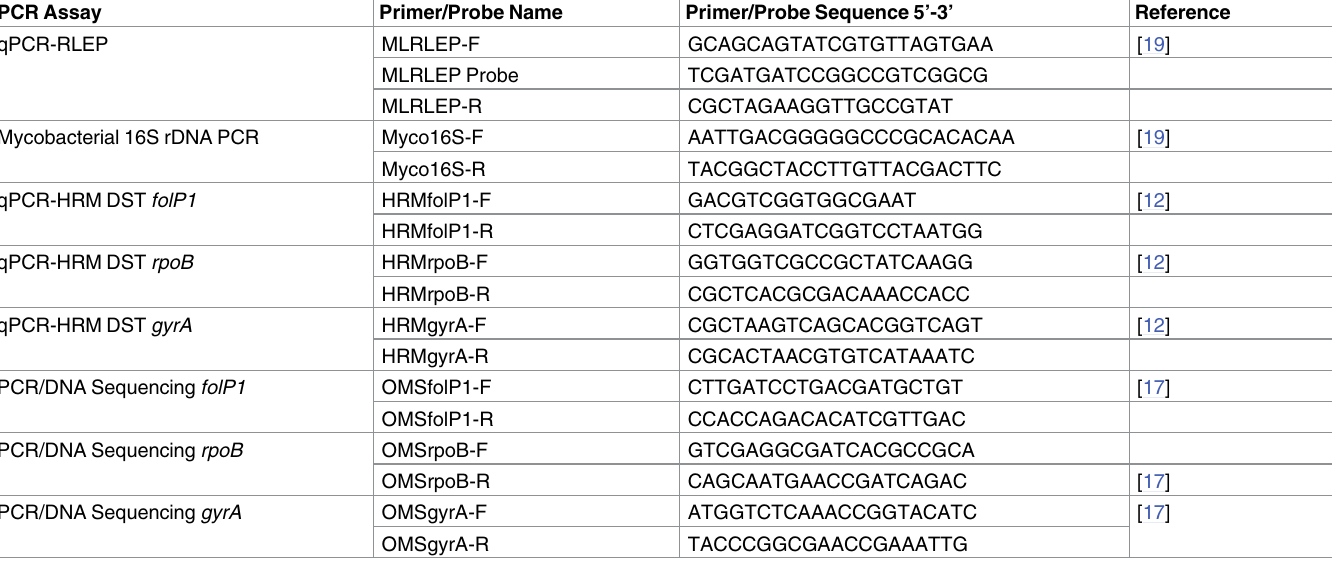
Table 1. Primers and probe used in the comparison of qPCR-HRM DST and PCR/direct DNA sequencing for drug susceptibility testing in M . leprae . PCR